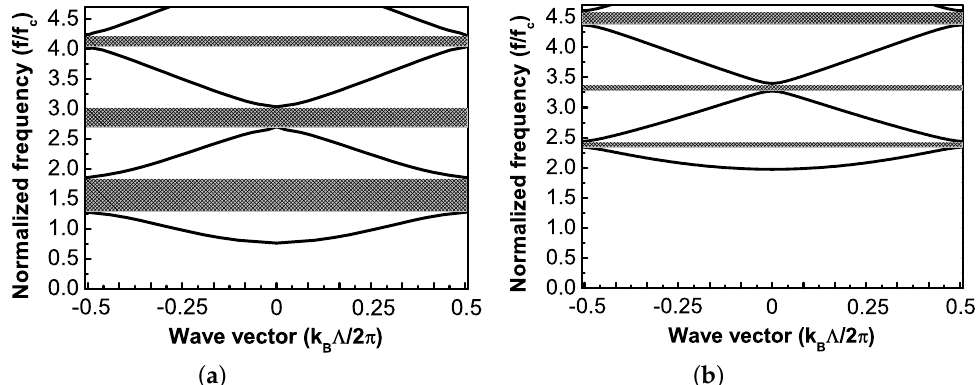
Figure 4. Band structures of ( a ) TE 10 and ( b ) TM 11 modes for the quasi-1D PC with the dielectric constants ε 1 = 3.8, ε 2 = 1 and the thicknesses t 1 = 1.00 mm, t 2 = 3.30 mm, corresponding to a filling ratio of 23.26%. The PBGs of TE 10 mode show no overlap with those of TM 11 mode.